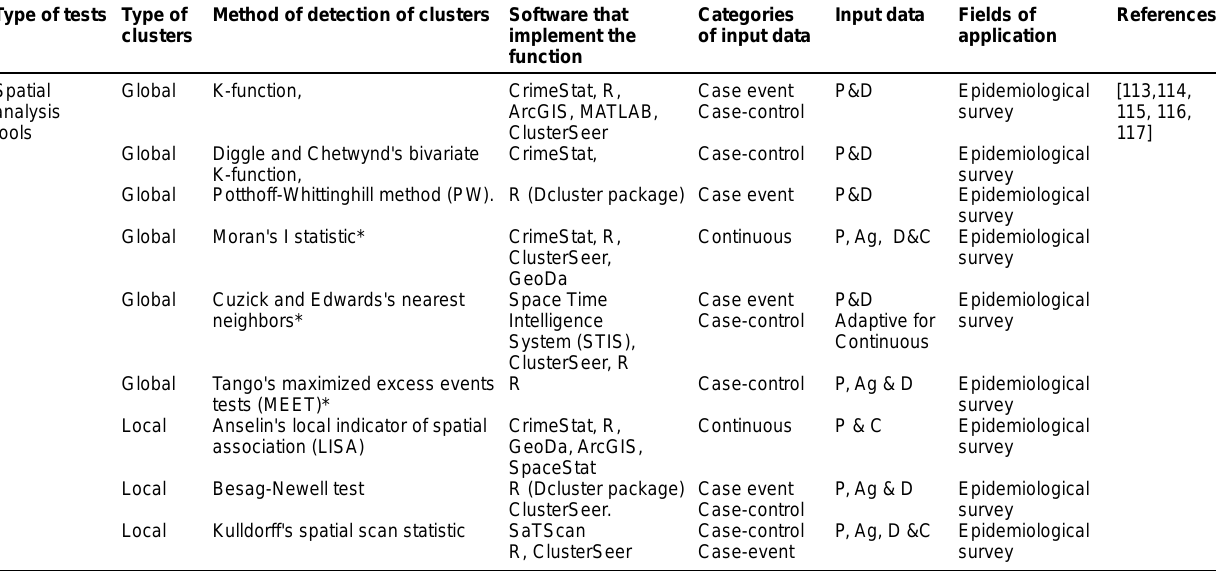
Table-2. Characteristics of statistical tools use for diseases clusters detection Type of tests Type